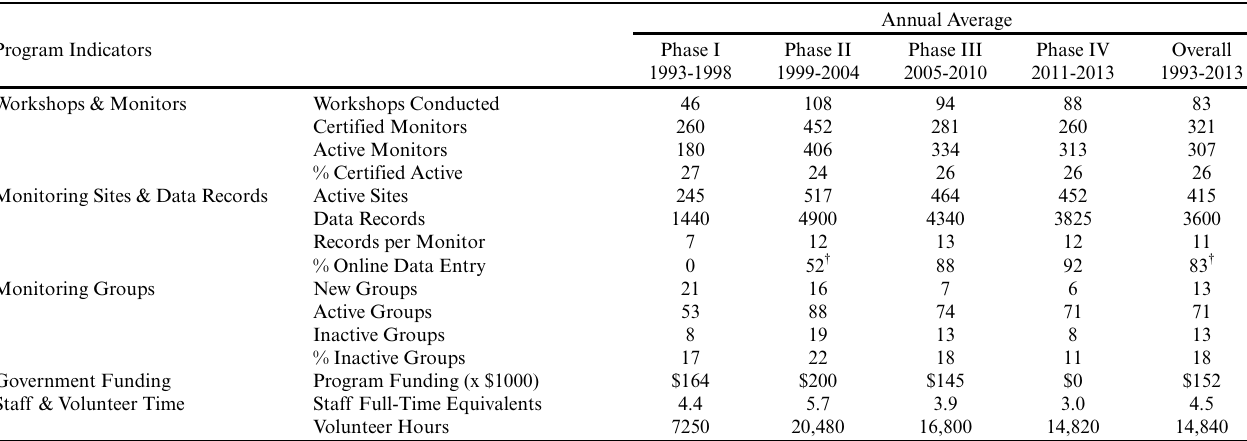
Table 2 . Alabama Water Watch program indicators as annual averages within each of four phases, with overall annual average, 1993-2013.